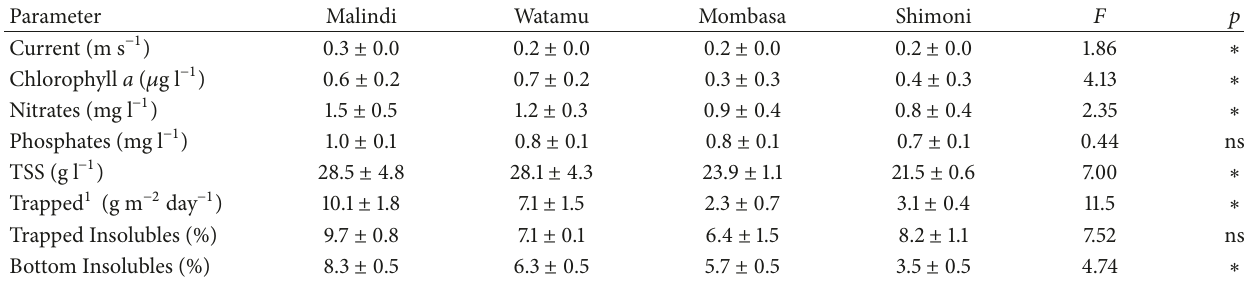
Table 1: Environmental parameters measured for each reef from thestudy with significant levels indicated by ∗ < 0.05 and ns = nonsignificant. 1 Trapped (deposited sediments) collected from sediment